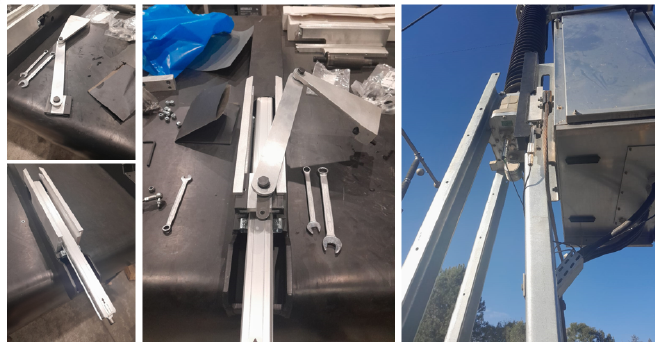
Figure 18. Linear encoder installed on the